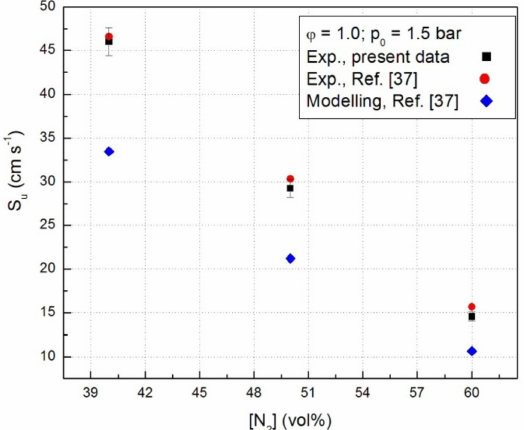
Figure 6. Laminar combustion velocities of stoichiometric N 2 -diluted CH 4 -N 2 O flames at constant initial